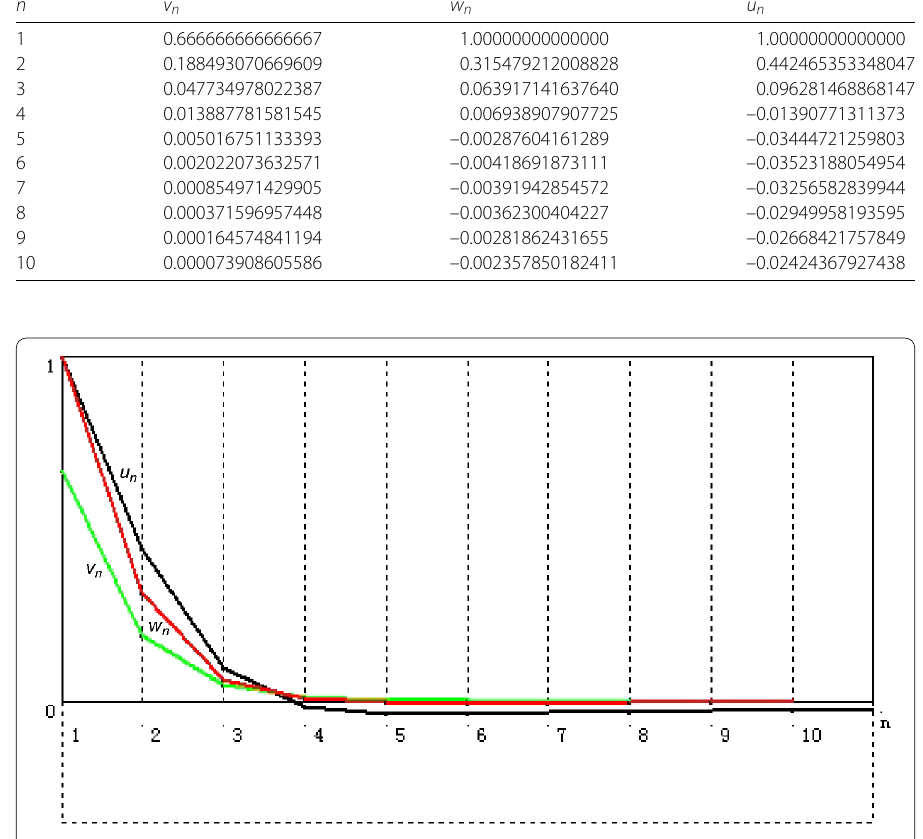
Table 1 Numerical results of { u n } , { v n } , and { w n } with initial u 1 = 1.0 n v n w n u n 1